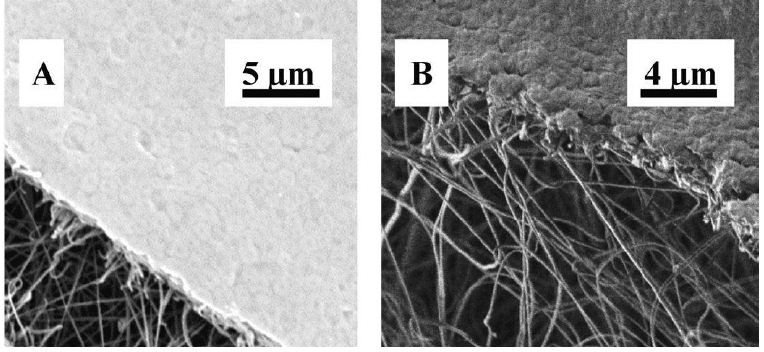
Figure 7. SEM images showing ( A ) surface and ( B ) cross-section views of PAN/PET hybrid ENM after E. coli suspension filtration